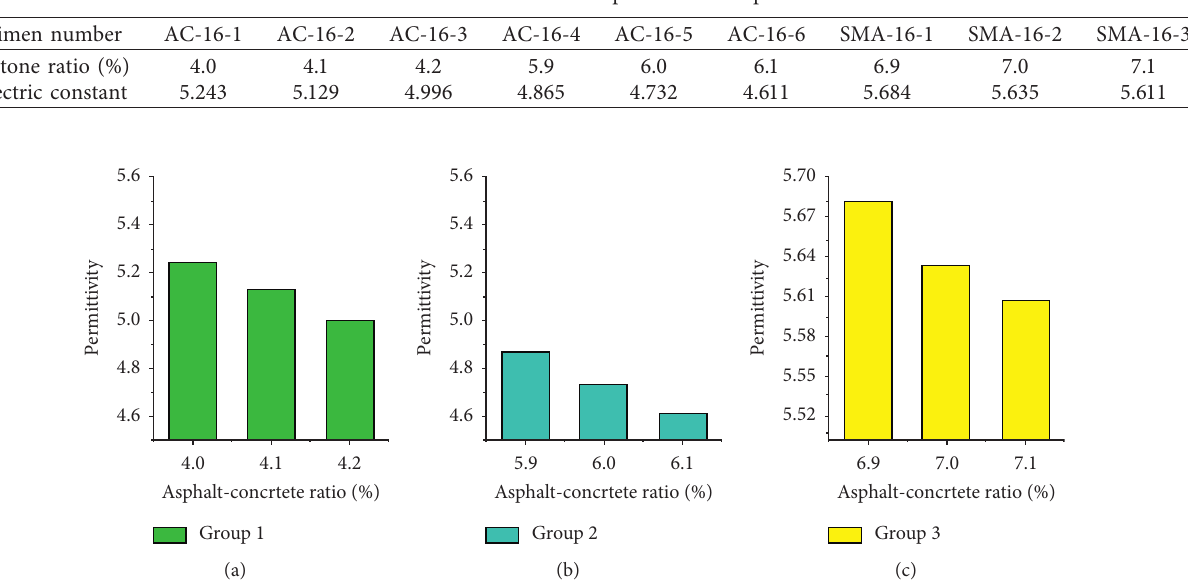
Figure 4: Variation of dielectric constant with the oil-stone ratio of the